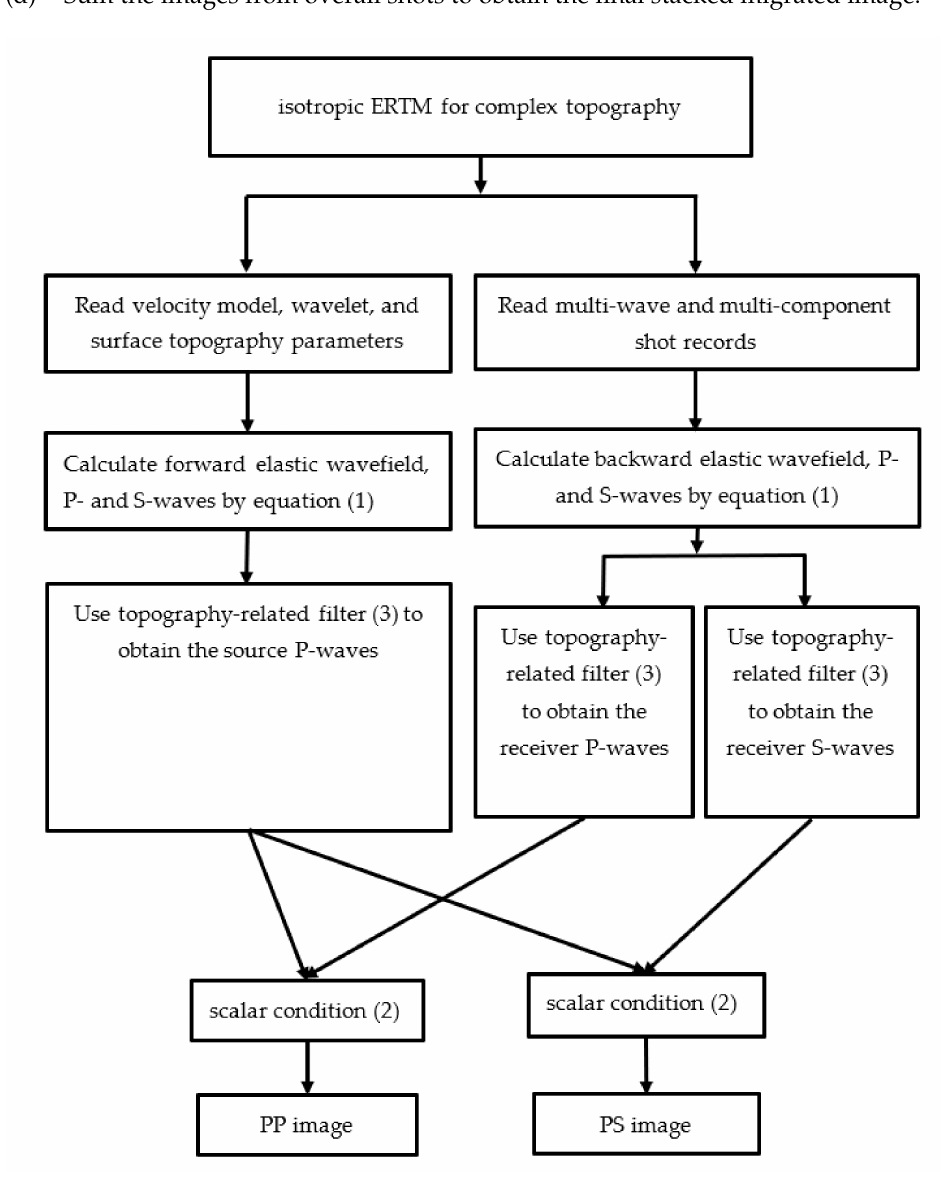
Figure 2. The workflow for the proposed isotropic